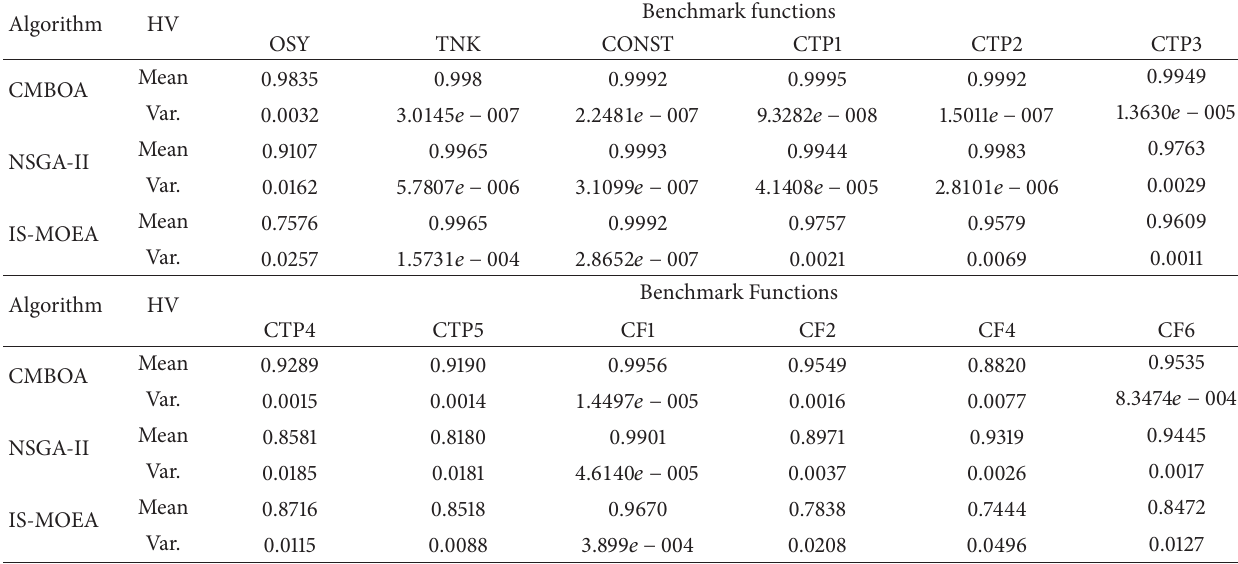
Table 5: Mean and variance (Var.) of the hypervolume (HV) metric.